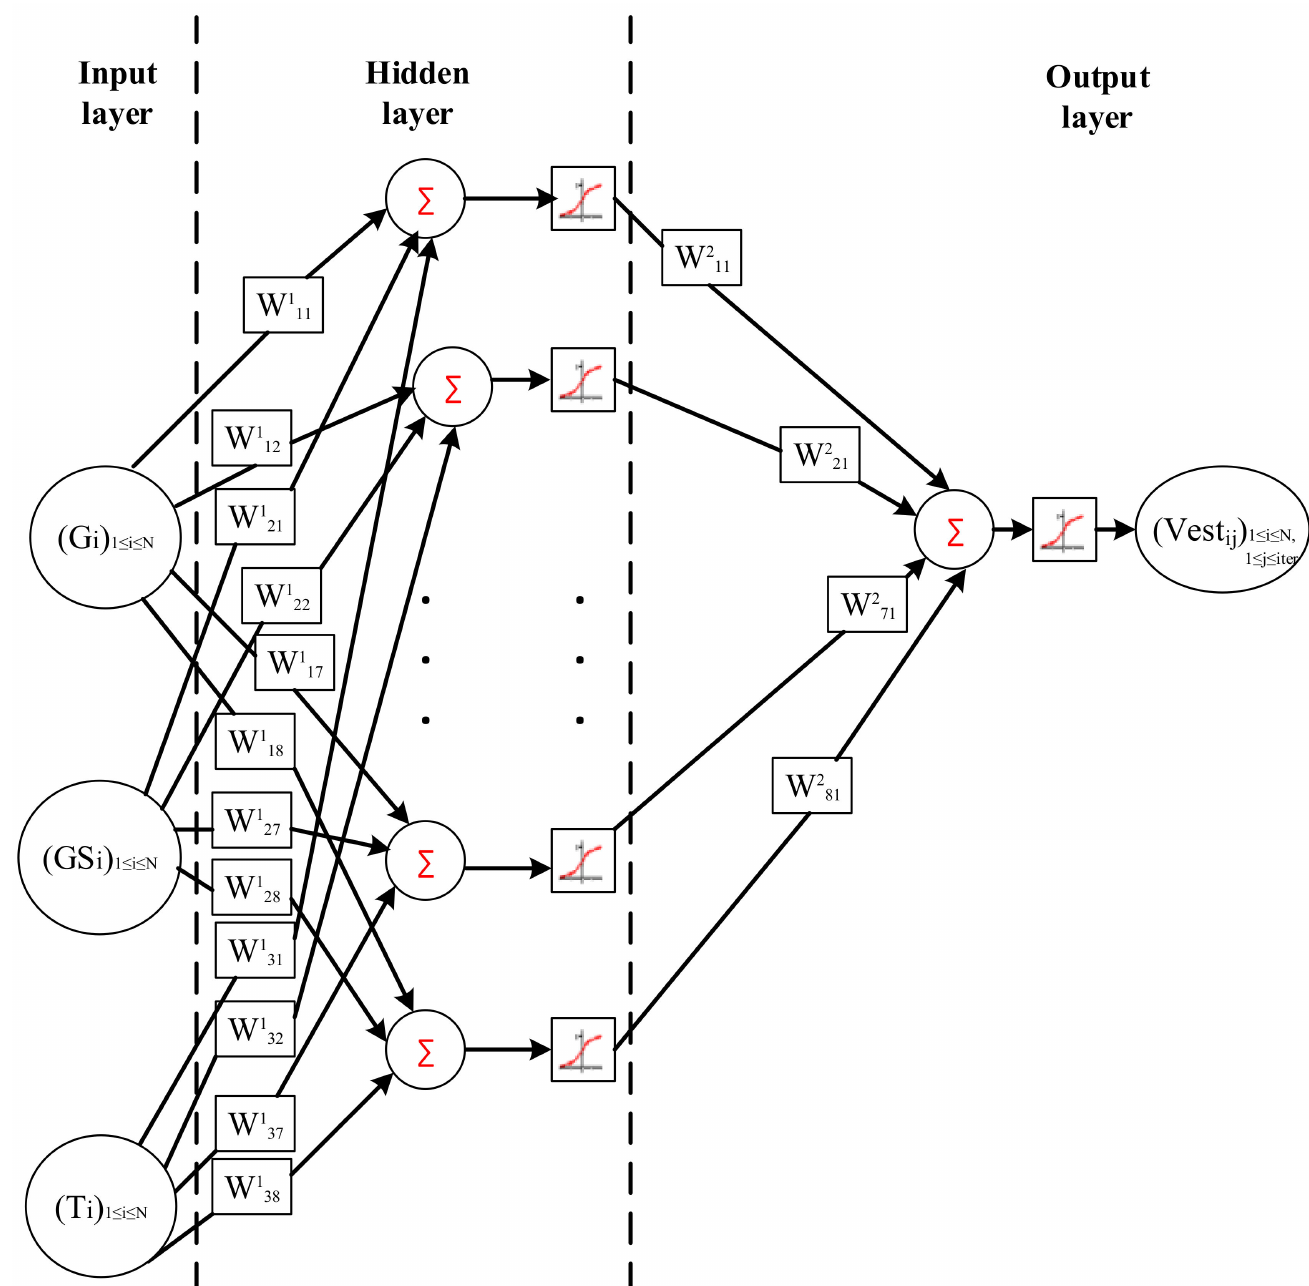
Figure 5. Configuration of the utilized NN under partial shading. The main idea of the NN-P&O algorithm is using the NN controller to predict the voltage value ( Vest ) during the variation in irradiation in the shaded and non-shaded areas, respectively; ∆ G and ∆ GS are different to zero. Otherwise, the P&O method in- volves a very small step size to reach the MPP. This algorithm is presented in a flowchart (Figure